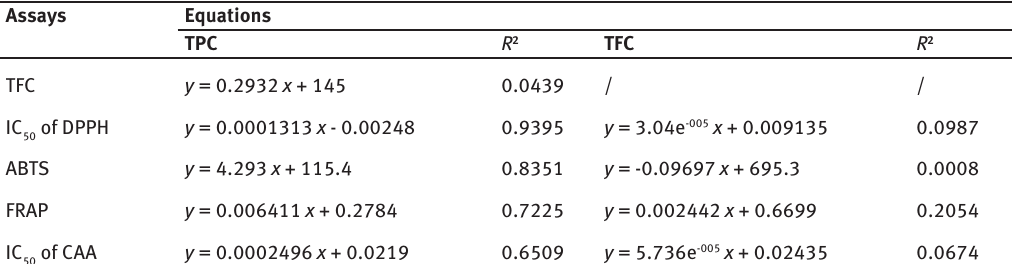
Table 3: Correlations between phenolic contents and antioxidant activities. Assays